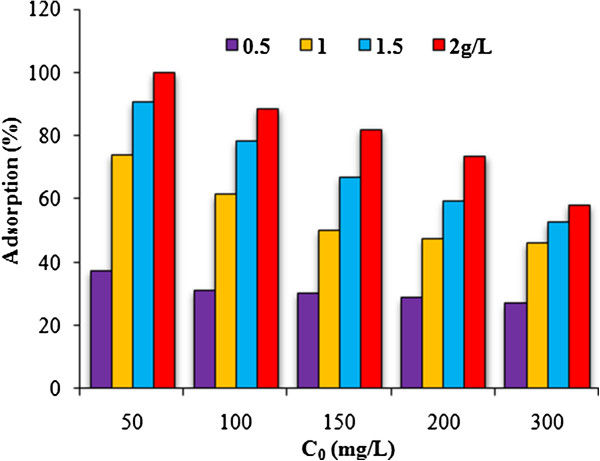
Effect of various aniline concentrations on its adsorption upon AC-Fe3O4 magnetic nanoparticles: pH = 6, t = 300 min, C0 = 50-300 mg/L W = 0.5-2 g/L and T = 20°C.